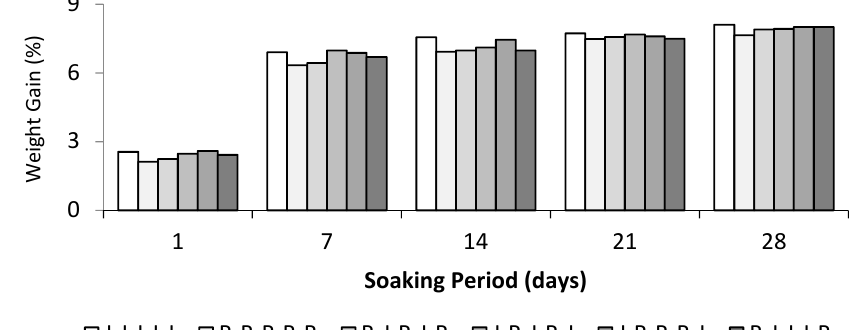
Figure 6. Water absorption of pure and hybrid jute–ramie composites.